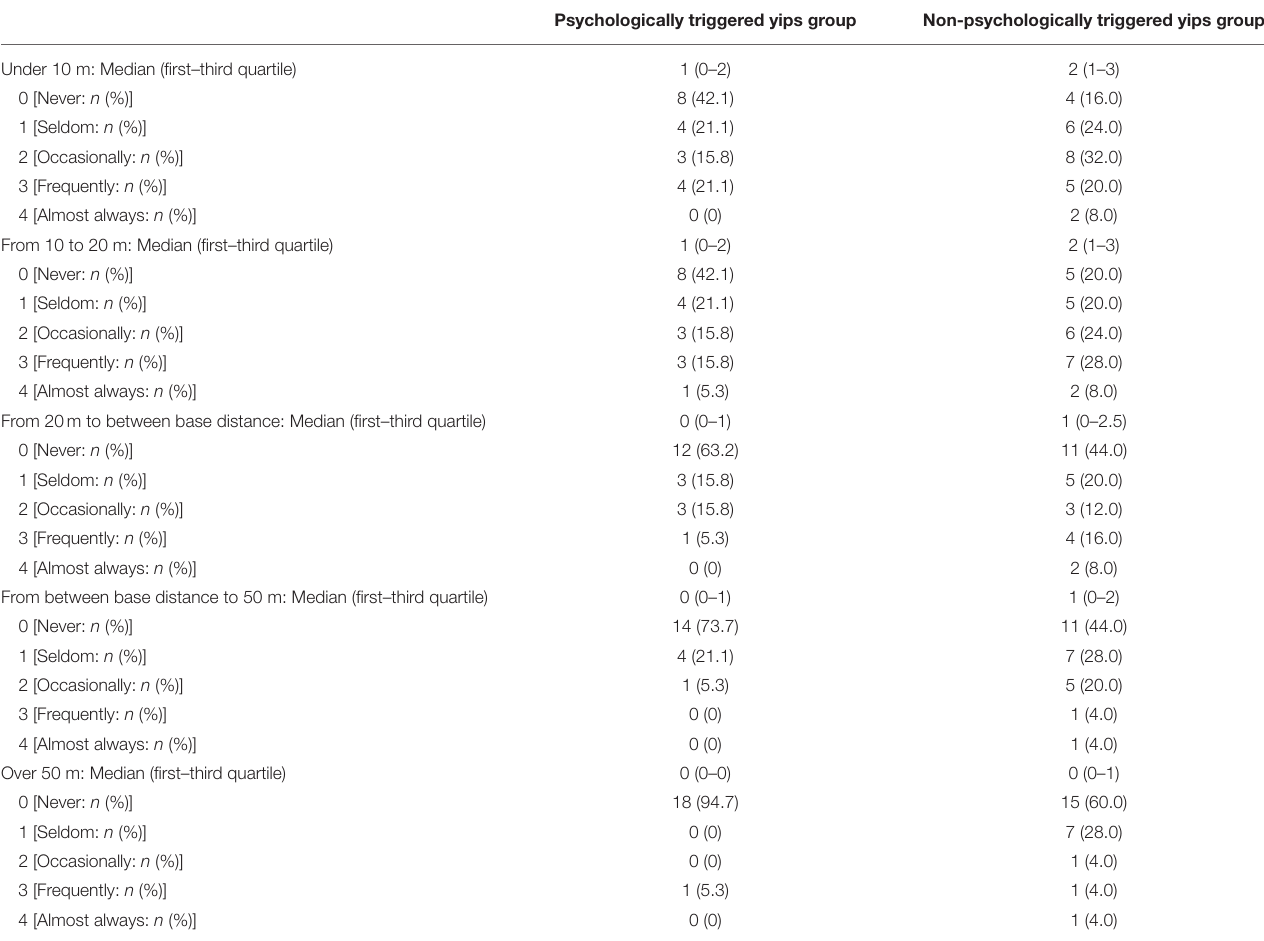
TABLE 2 | Relationship between frequency of throwing errors and throwing distance. Psychologically triggered yips group Non-psychologically triggered yips group